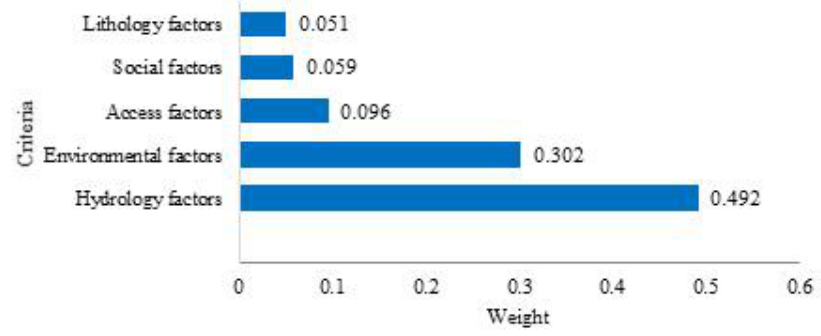
Fig.3: The determination of the weight of the criteria in the Analytic hierarchy process